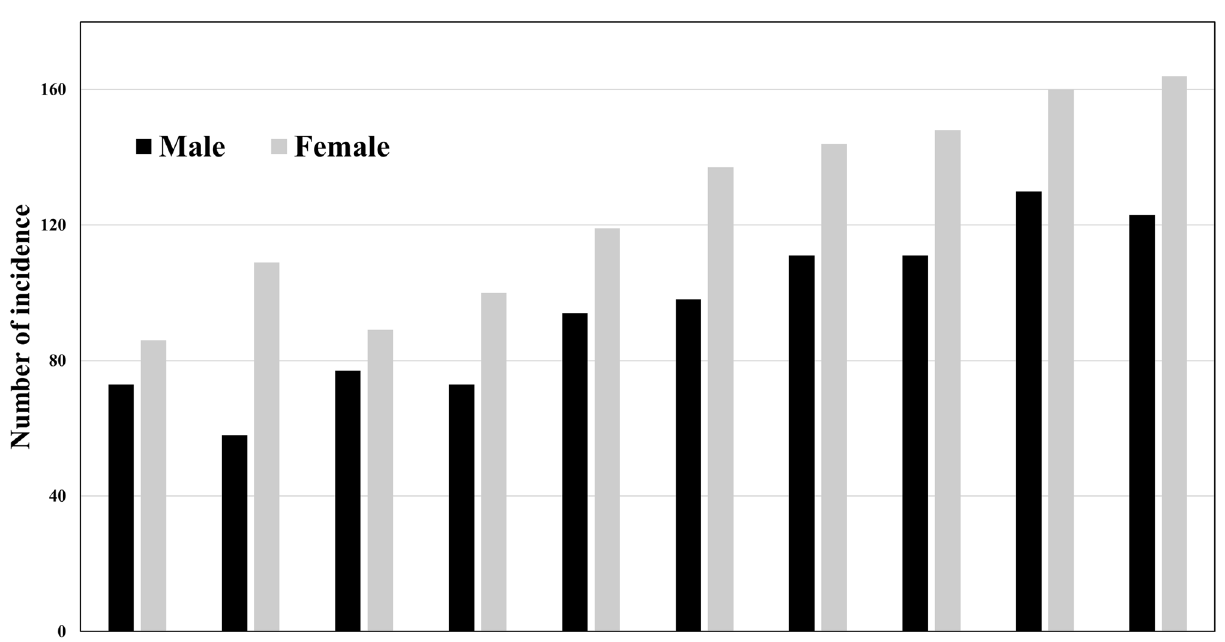
Figure 4. Numbers of Creutzfeldt–Jakob Disease incidence by sex, 2005–2014. The numbers of CJD incidence in each year stratified by sex are shown. The number of CJD incidence continuously increased in females over the entire study period, while it reached a peak in 2013 in